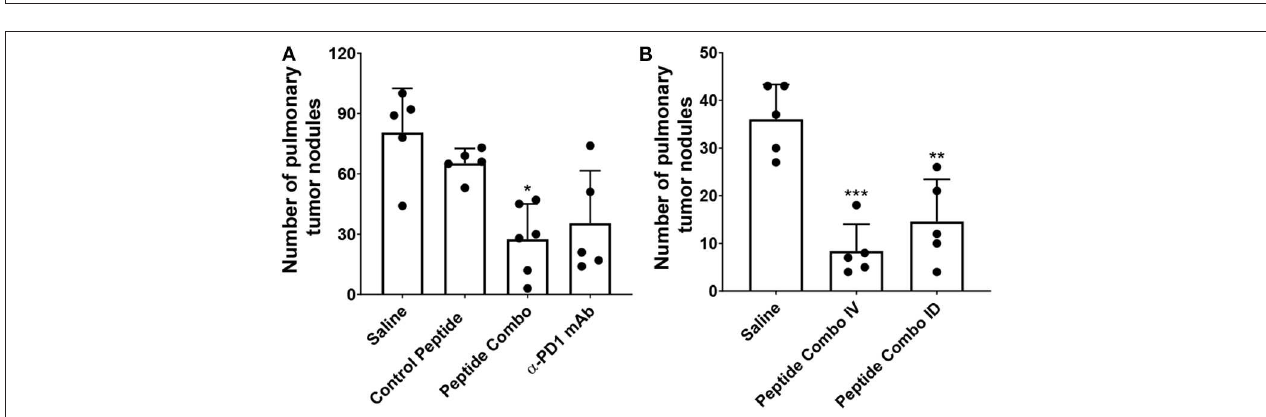
FIGURE 4 | (A) Molecular docking of PD1 binding peptides to PD1. Experimentally determined binding pose for human PD-L1 is shown superimposed with the top predicted poses for peptides SQ20, QP20, HD20, and WQ20 docked on human PD1. (B) Zoomed-in view of predicted poses for peptides. Note that SH20 (clone 75 in Figure 1 ) is another peptide that was also isolated as a PD1 binder in the phage library screen and is shown here for comparison to the four peptides.